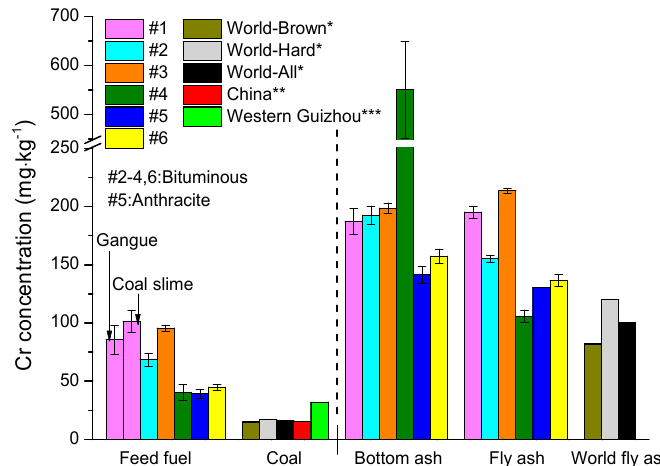
Figure 3. Cr concentration in the feed fuels and bottom/fly ashes of different CFPPs. * From Ketris and Yudovich [47]; ** From Dai et al. [29]; *** From Dai et al. [45].